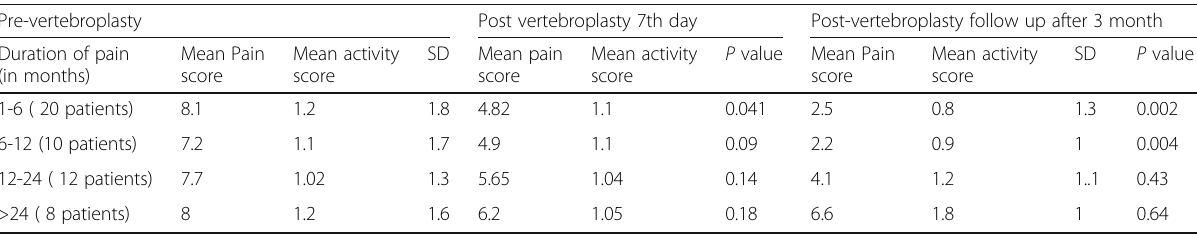
Table 6 Correlation between duration of pain and amount of pain relief post procedure Pre-vertebroplasty Post vertebroplasty 7th day Post-vertebroplasty follow up after 3 month Duration of pain (in